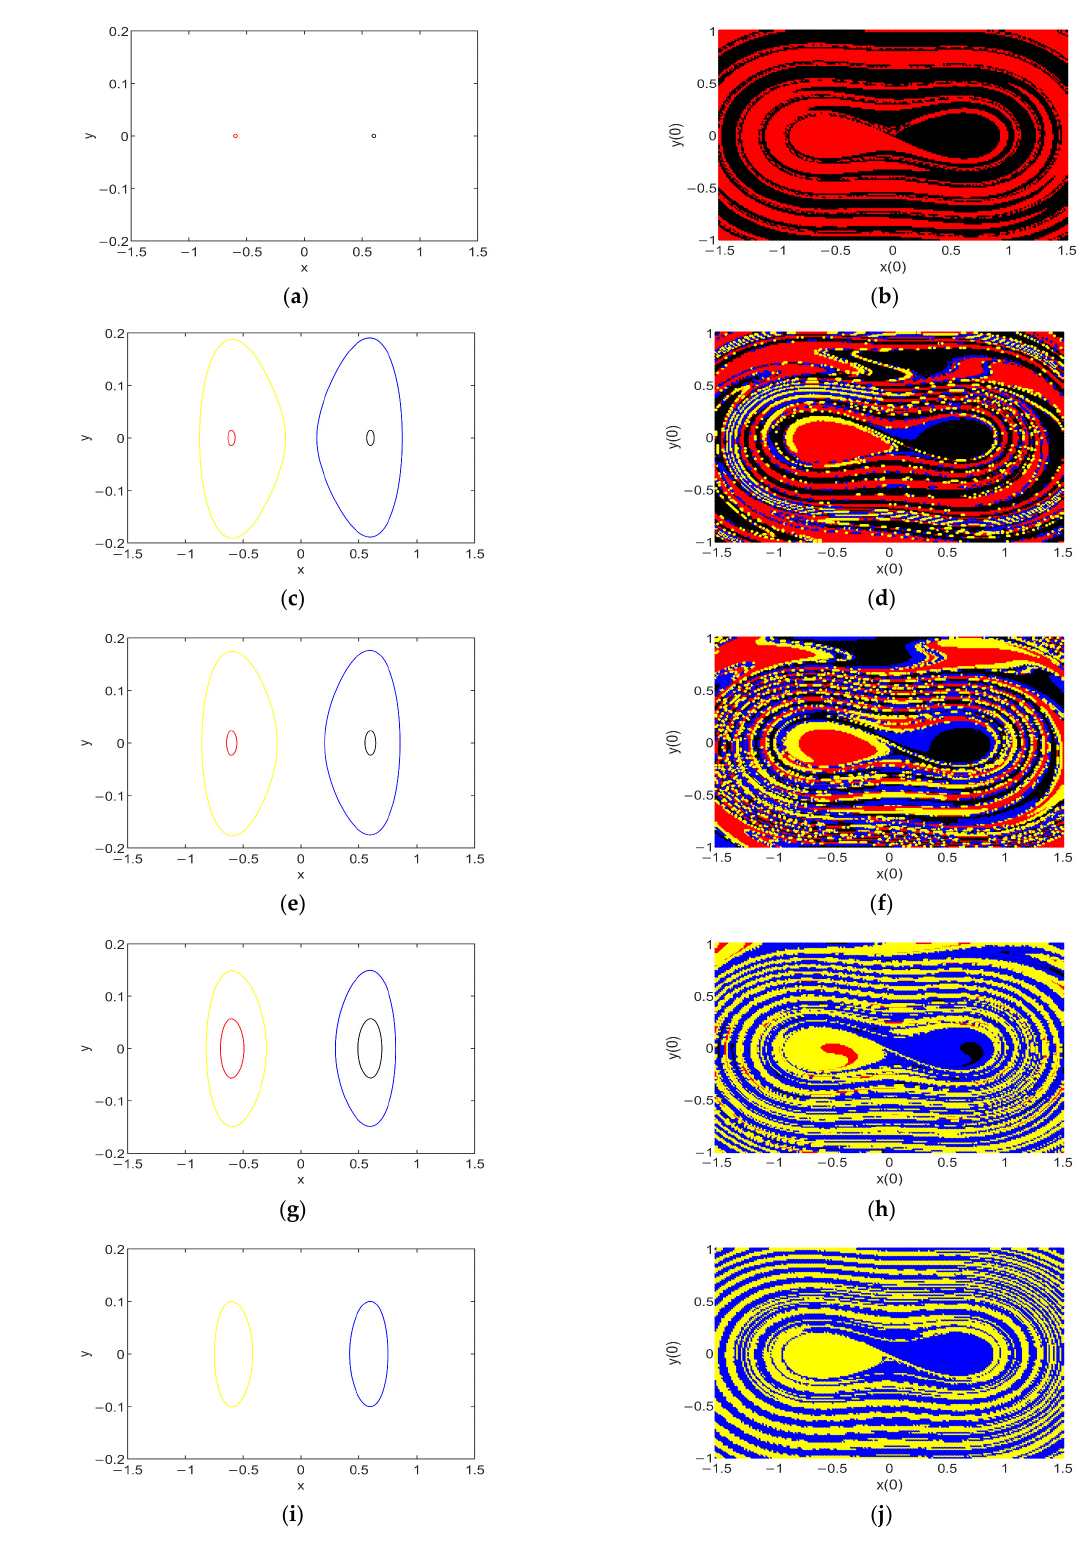
Figure 7. Sequences of coexisting attractors and their BA with the variation in ω for f 0 = 0.005: ( a ) phase map of the attractors for ω = 0.2; ( b ) basins of attraction for ω = 0.2; ( c ) phase map of the attractors for ω = 0.45; ( d ) basins of attraction for ω = 0.45; ( e ) phase map of the attractors for ω = 0.50; ( f ) basins of attraction for ω = 0.50; ( g ) phase map of the attractors for ω = 0.55; ( h ) basins of attraction for ω = 0.55; ( i ) phase map of the a tt ractors for ω = 0.60; and ( j ) basins of a tt raction for ω = 0.60. For ω = 0.50, the sequences of the coexisting a tt ractors and the extent of their BA with an increase in the dimensionless excitation amplitude f 0 can be observed in Figure 8, which is more complicated than the evolution in Figure 7.